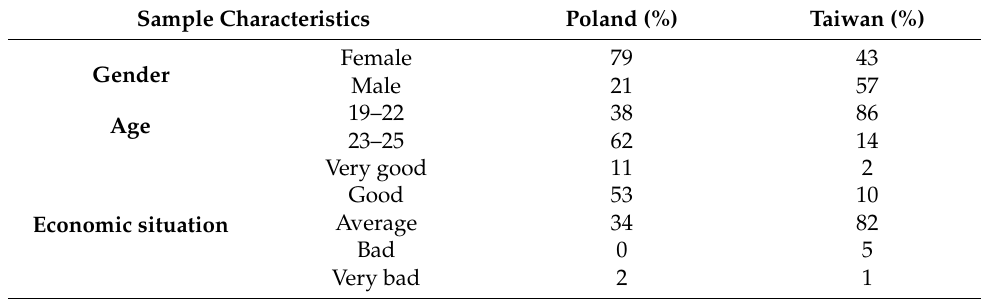
Table 1. Characteristics of the sample (N = 200).